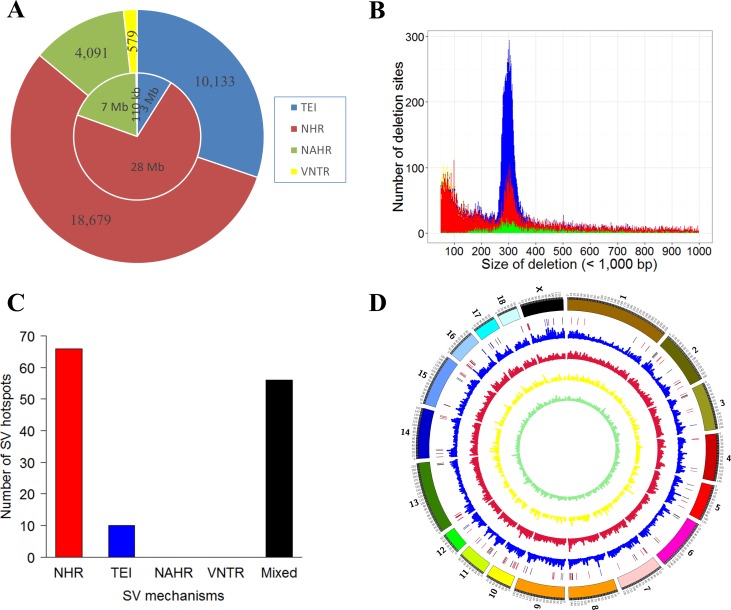
SV formation mechanisms of 66 Chinese pigs.(A) Pie chart of formation mechanisms (33,482 SVs) of recalibrated deletions. The inner and outside circles represent the lengths and occurrence numbers of all recalibrated SVs, respectively. (B) Length distribution of different forms of deletions. Color reference is same as in A. (C) Formation mechanisms of deletions in SV hotspots. (D) Distribution of deletions generated by different formation mechanisms in the whole genome. The highlight red, blue and black regions represent hotspot of NHR, TEI and mixed distributions, respectively. Color reference of the inner circles is same as in A.